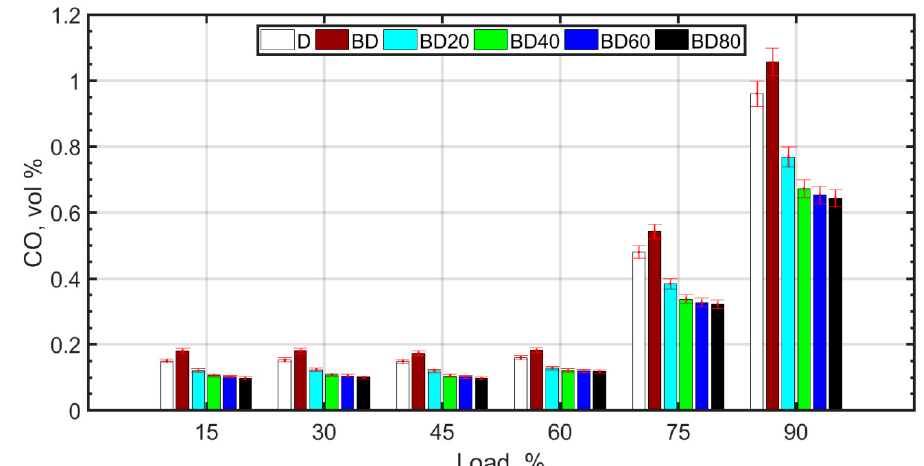
Figure 6. CO 2 variation with load.